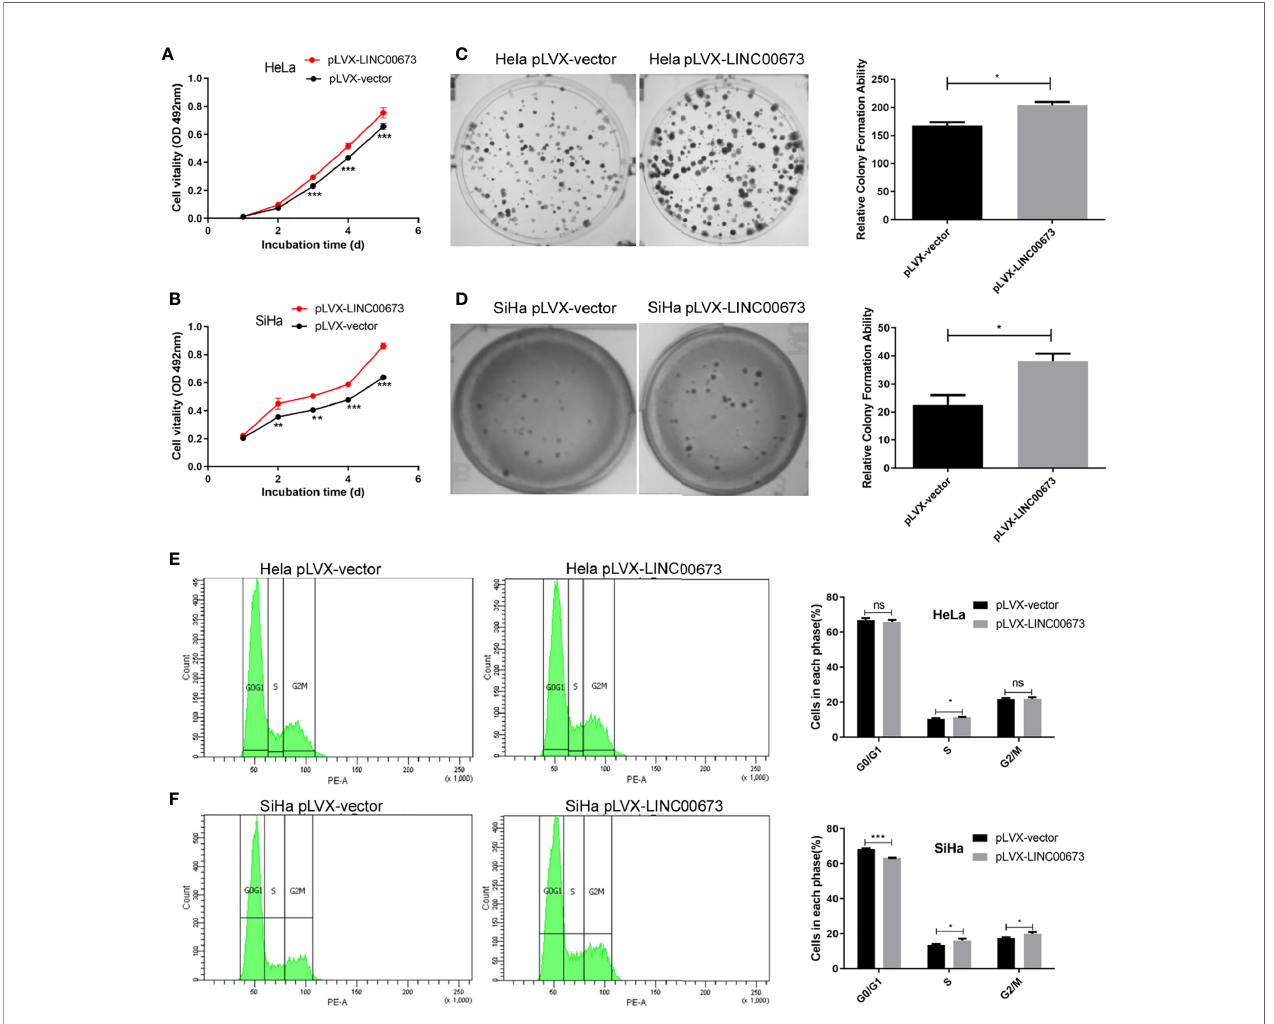
FIGURE 2 | LINC00673 promotes the proliferation, colony formation and cell cycle of cervical cancer cells. Experiments were performed in stable cell lines with lentivirus-mediated overexpression of LINC00673 or controls. (A, B) MTT proliferation assay indicated that LINC00673 increases cell proliferation in both HeLa cells and SiHa cells. (C, D) LINC00673 promotes the colony formation ability of HeLa and SiHa cells. The bar chart shows the corresponding colony formation number. (E, F) Cell cycle distributions of (E) HeLa cells and (F) SiHa cells overexpressing LINC00673 and control cells were examined using fl ow cytometry. Percentages of cells in each phase are indicated. Data are presented as mean ± SD (N = 3); * P < 0.05, ** P < 0.01, *** P < 0.001. Student ’ s t -test. ns, not statistically signi fi